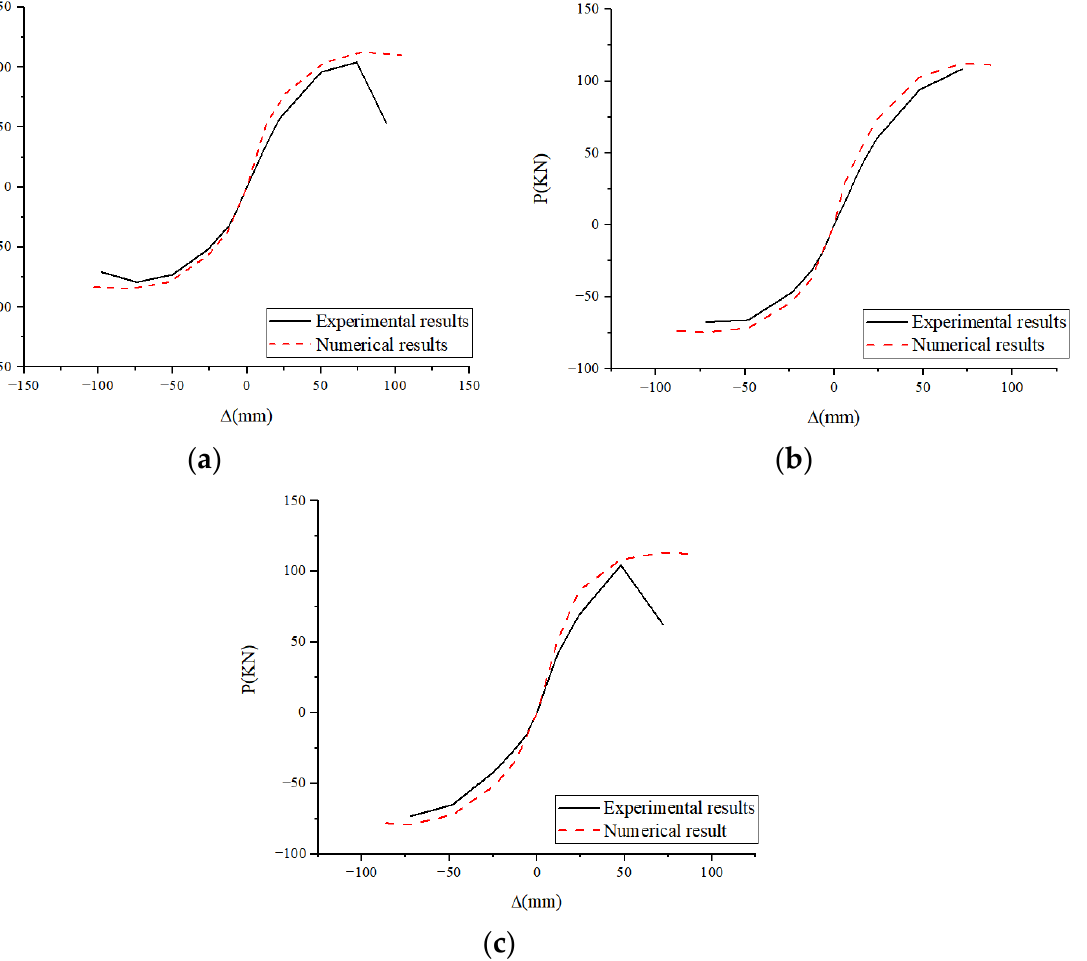
Figure 11. Comparison of skeleton curves of three specimens: ( a ) specimen C-1; ( b ) specimen C-2; ( c ) specimen C-3.